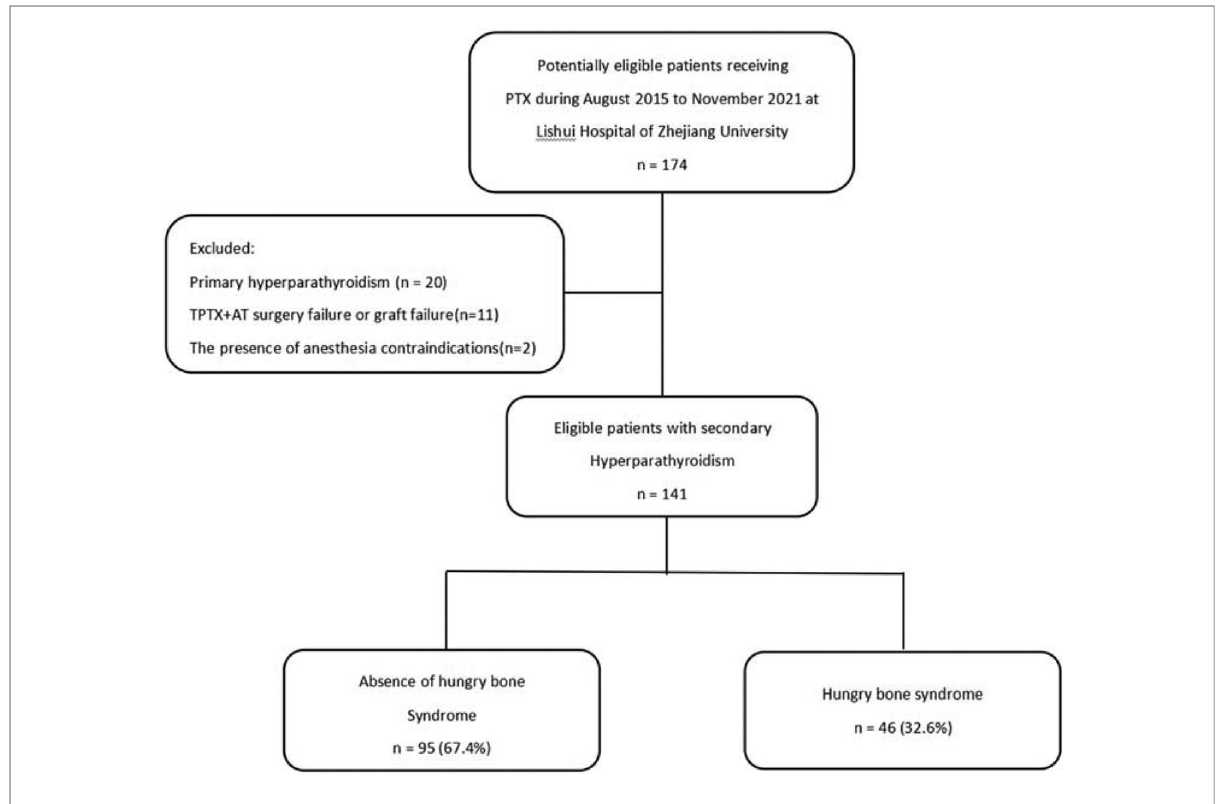
FIGURE 1 Subject disposition for the study cohort.